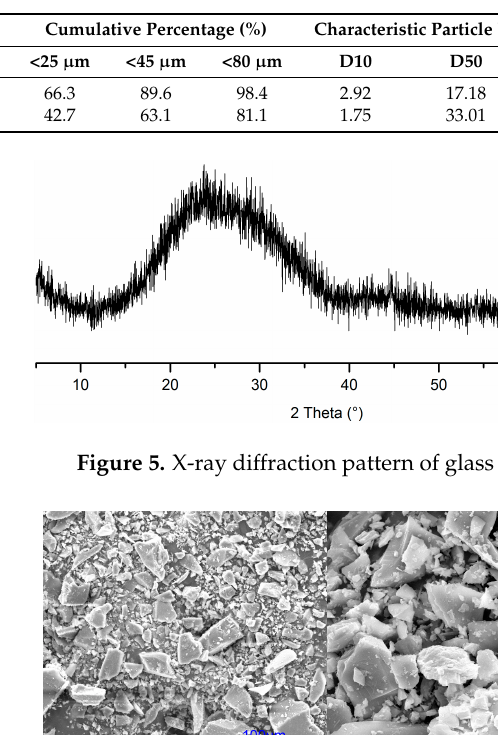
Figure 6. Scanning electron microscope (SEM) pictures of raw glass powder.